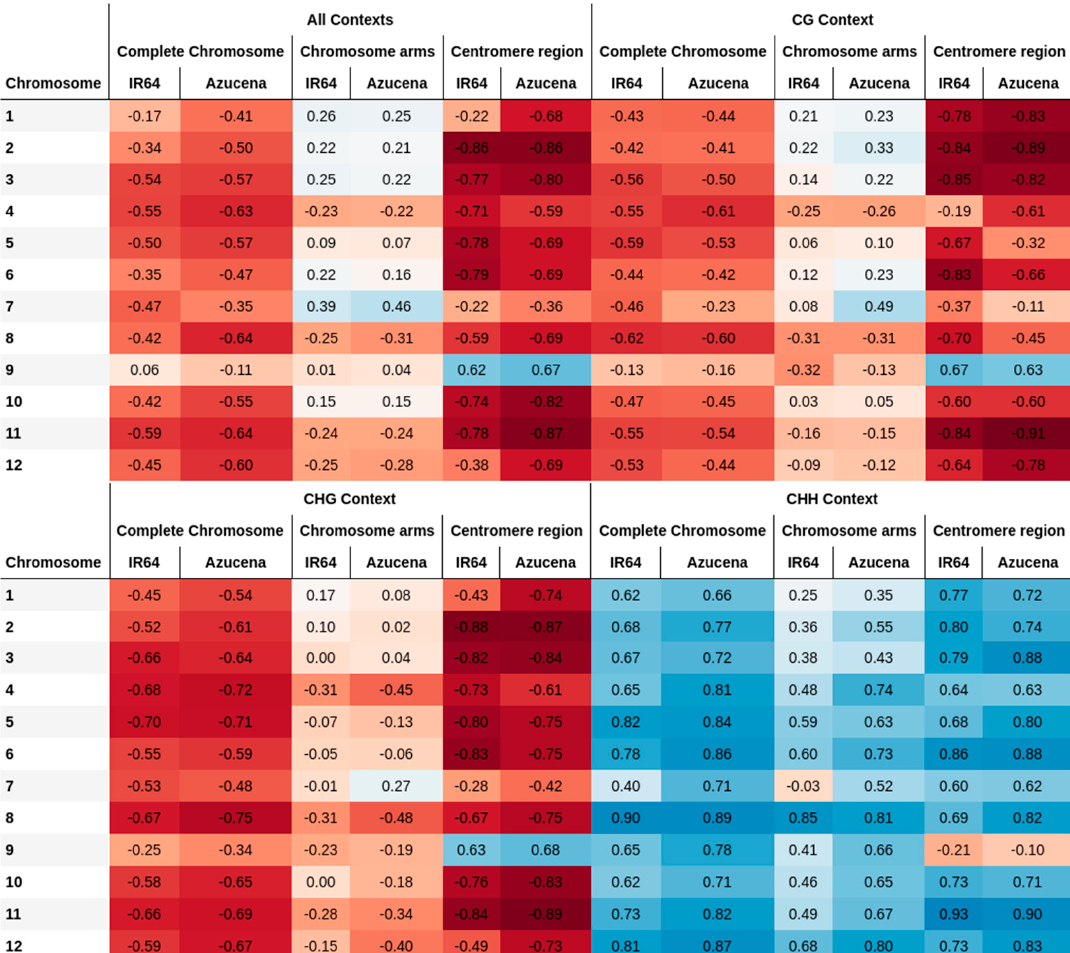
Figure 6. Correlations between recombination rates and the count of methylated cytosines for complete chromosomes, chromosome arms, and centromere region of rice varieties IR64 and Azucena. Blue and red colors correspond to positive and negative correlations, respectively. The higher the correlation value, the higher the color intensity.